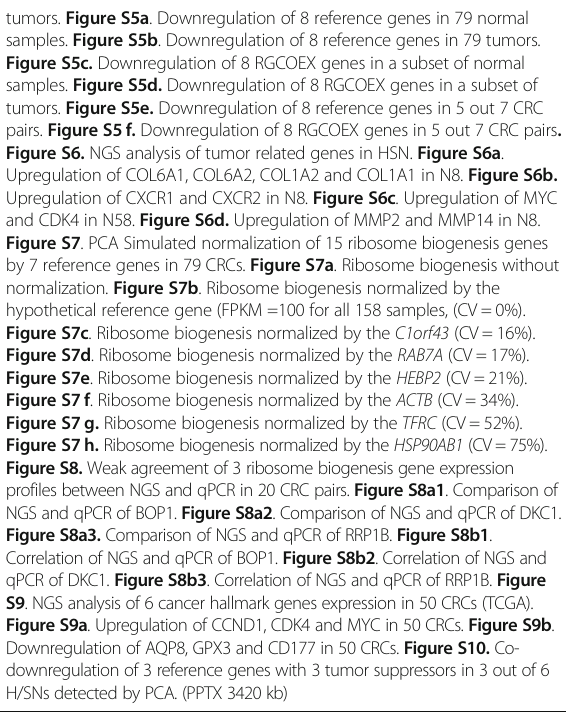
Figure S2a. Upregulation trend of 21 genes classical reference genes in 79 CRC pairs. Figure S2b. Upregulation of GAPDH in a subset of LST and HST. Figure S2c. Up and Down regulation of ACTB in a subset of LST and HST. Figure S2d. Up and Down regulation of B2M in a subset of LST and HST. Figure S3. Expression of 8 reference genes between HST and LST. Figure S3a .Selection of 8 reference gene CVs between 53 high stage HSTs and 26 LSTs (t-test: P =0.0003). Figure S3b. Fourfold downregulation of 8 reference genes in 15 out 17 of HSTs detected by PCA. Figure S3c. Fourfold downregulation of 8 reference genes in 5 out 7 of H/ LSNs detected by PCA. For stacked log 2 ratio plots, FPKMs of 79 tumors and 79 normal samples were only normalized by the mean of FPKM of 26 LSNs for each gene since HSNs were more likely to have dysregulation. Figure S4. Downregulation of 8 RGCOEX genes in a subset of tumors and normal controls. Figure S4a . Four fold downregulation of 8 RGCOEX genes in 12 out of 16 H/LSTs detected by PCA . Figure S4b . Downregulation of 8 RGCOEX genes in 5 out 7 in H/LSNs detected by PCA . For stacked log 2 ratio plots, FPKMs of 79 tumors and 79 normal samples were only normalized by the mean of FPKM of 26 LSNs for each gene since HSNs were more likely to have dysregulation. Figure S5 . Downregulation of 8 reference genes, their 8 correlated genes and 10 tumor related genes in normal samples and